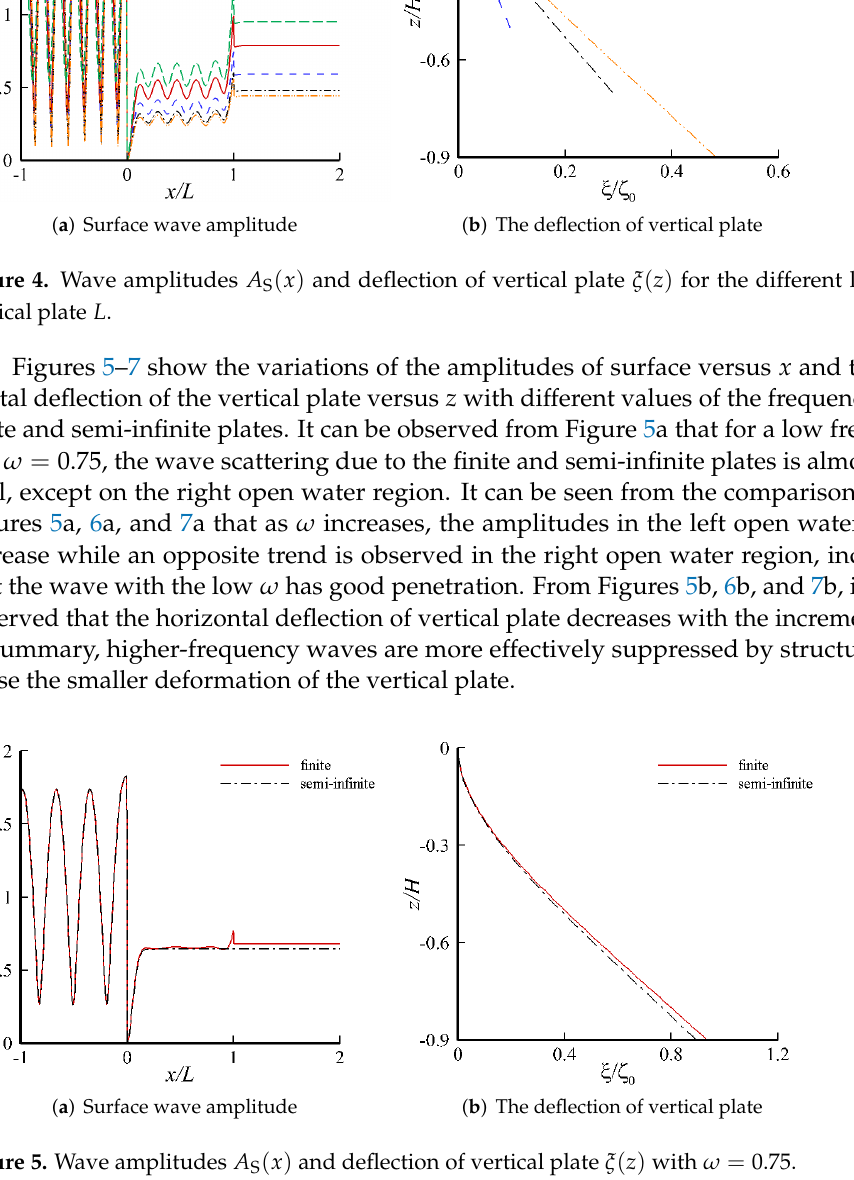
Figure 5. Wave amplitudes A S ( x ) and deflection of vertical plate ξ ( z ) with ω =